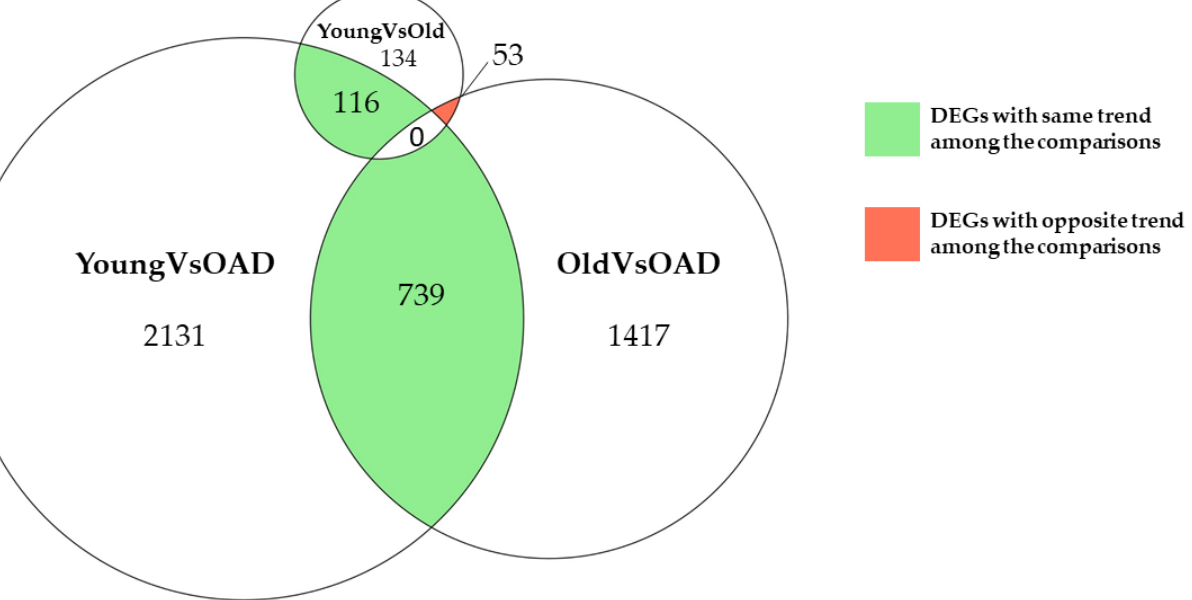
Table 1. Enriched pathways for DEGs commonly expressed among Young, Old, and OAD groups.